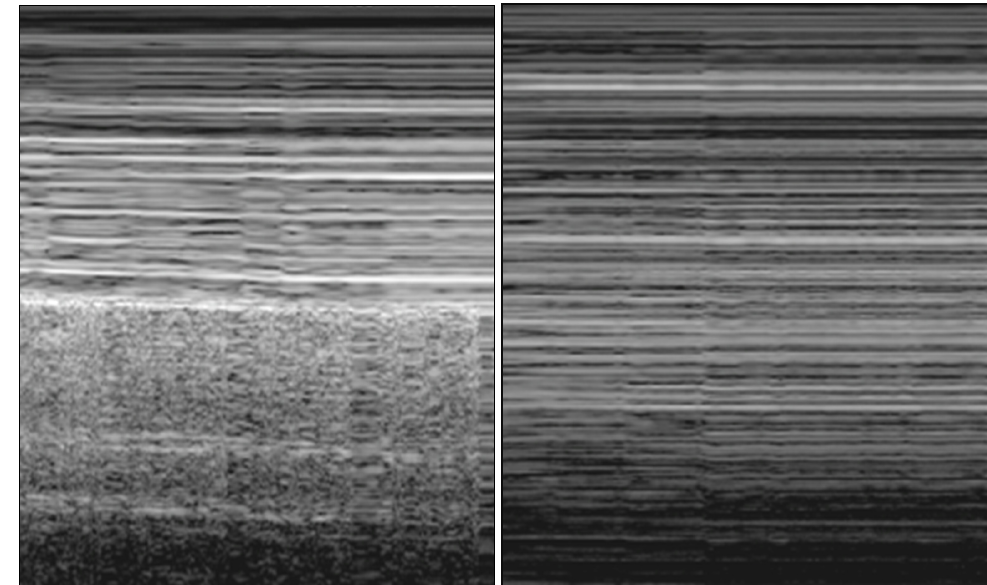
Figure 2. Lung point: “seashore sign” (left) turns into “stratosphere sign” (right) in M-mode view during deep inspiration.